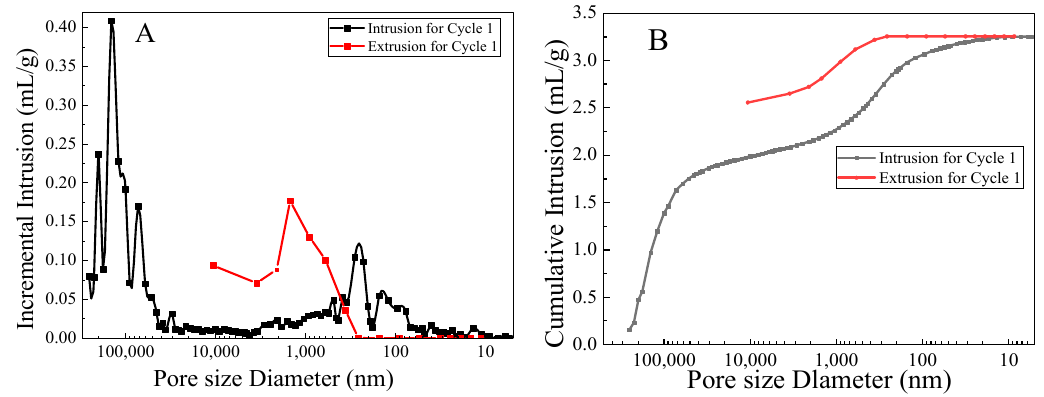
Figure 7. Pore size distribution ( A ) and cumulative pore volume ( B ) of COF .